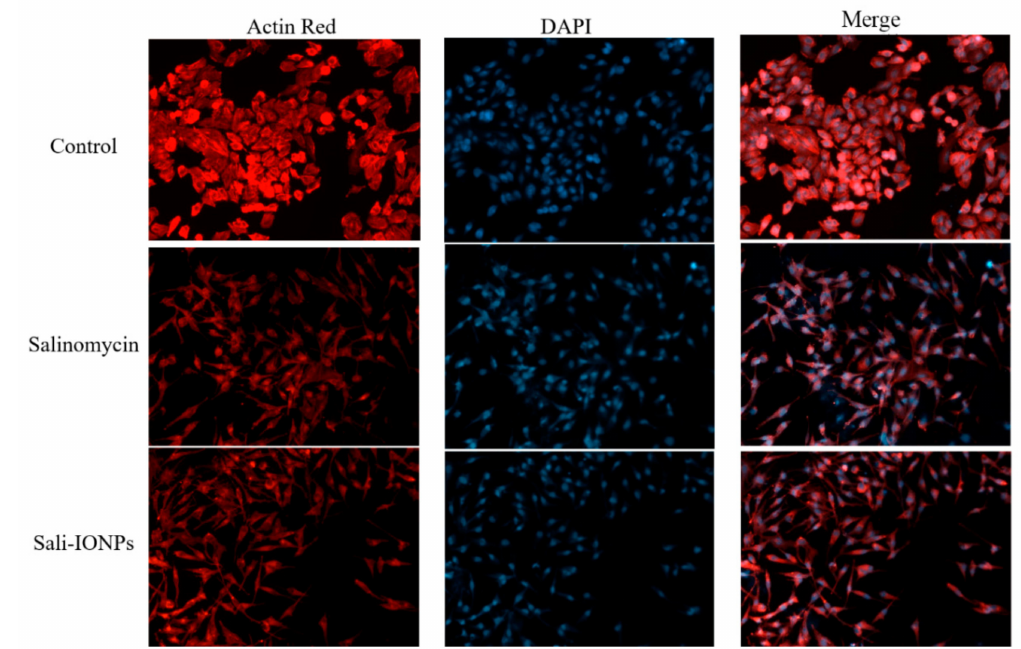
Figure 8. Fluorescence microscopy images of U251 treated with either salinomycin or Sali-IONPs after 48 h of the treatment. Red and blue fluorescence colors represent Alexa Fluor@ 488 phalloidin-stained F-actin and DAPI-stained cell nuclei,